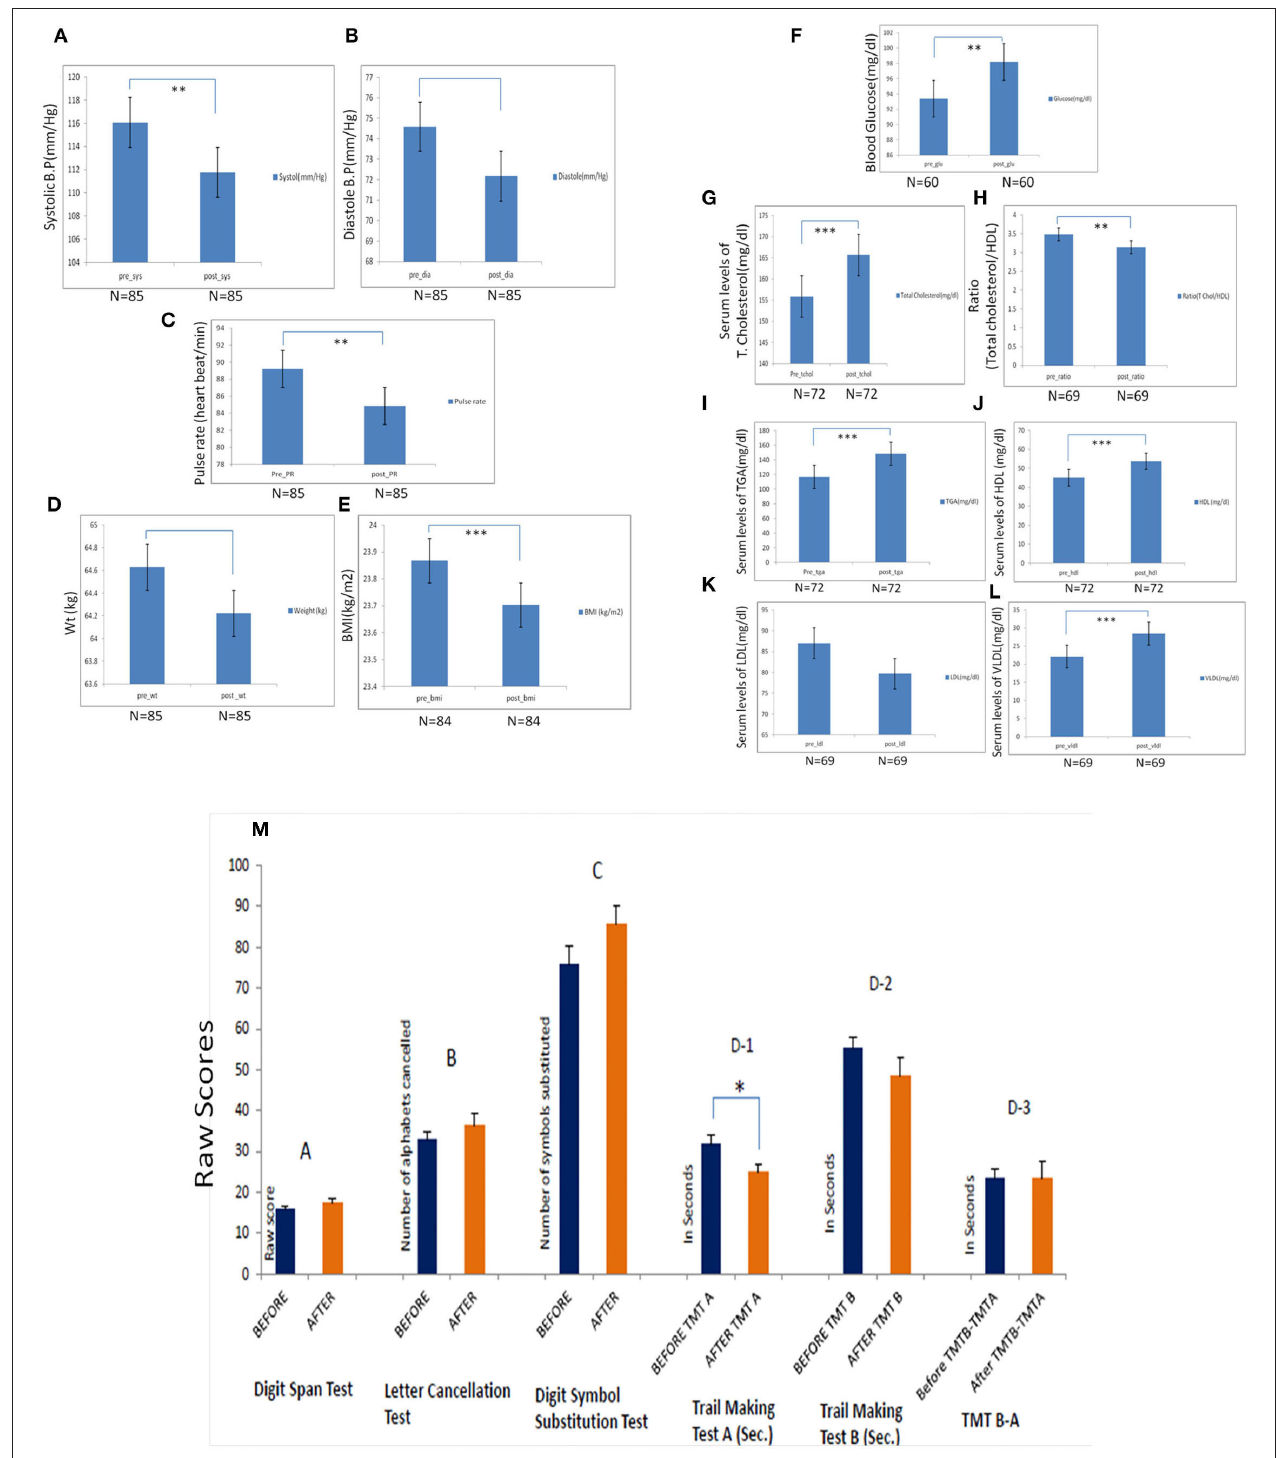
FIGURE 2 | Pre- and post-analysis of naïve participants by estimation of physiological parameters after the 1 month of yoga-based Common Yoga Protocol (CYP). (A) Significant changes in the systolic blood pressure following 1 month of the camp ( p = 0.001). (B) Changes in the diastolic blood pressure following 1 month of the camp ( p = 0.013). (D) Changes in weight following 1 month of the camp. (E) Changes in body mass index following 1 month of the camp ( p < 0.0001). Pre- and post-analysis of biochemical parameters after 1 month of the camp in naïve participants. (F) Pre- and post-serum levels of TG (mg/dl) total cholesterol (mg/dl) ( p = 0.0001). (G-I) Pre- and post-serum and post-serum levels of LDL, HDL, and VLDL (mg/dl). (J) Pre- and post-serum and post-ratio (total cholesterol/HDL) (mg/dl)